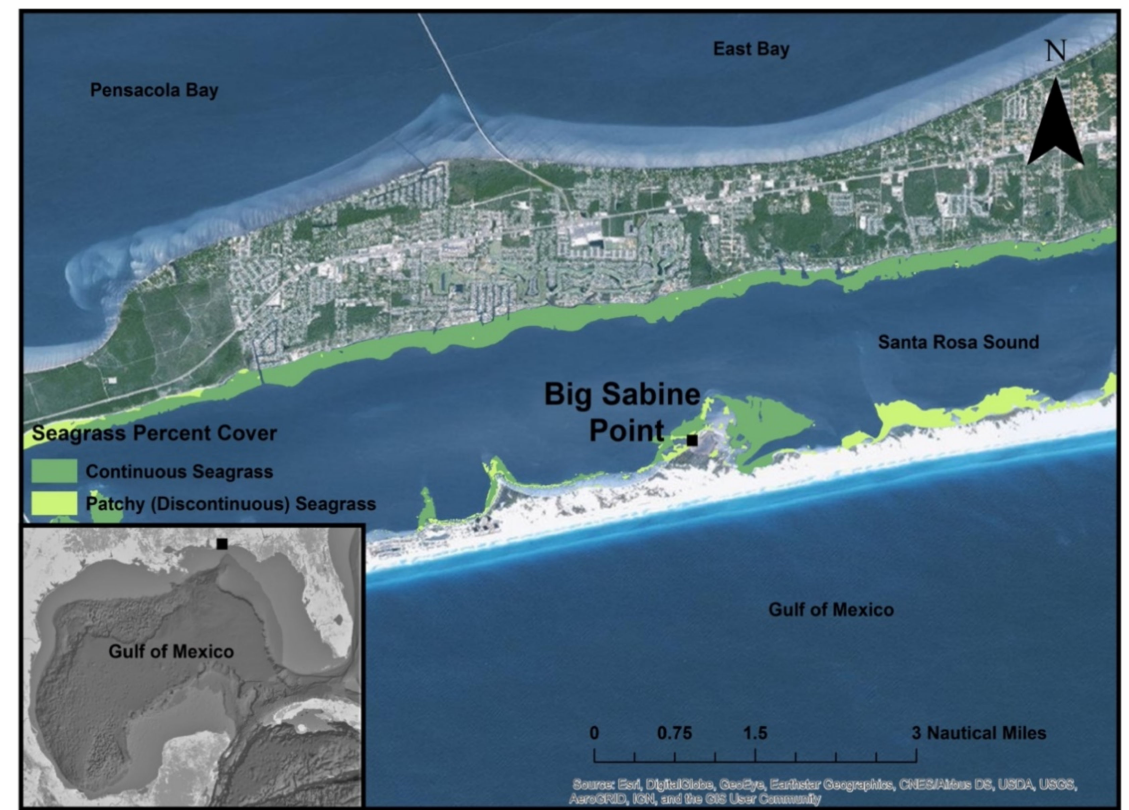
Figure 1. Location of sampling location at Big Sabine Point within the Pensacola Bay System and in relation to the Gulf of Mexico (ArcMap 10.4.1). Sampling at this site began in May 2015 and ended in September